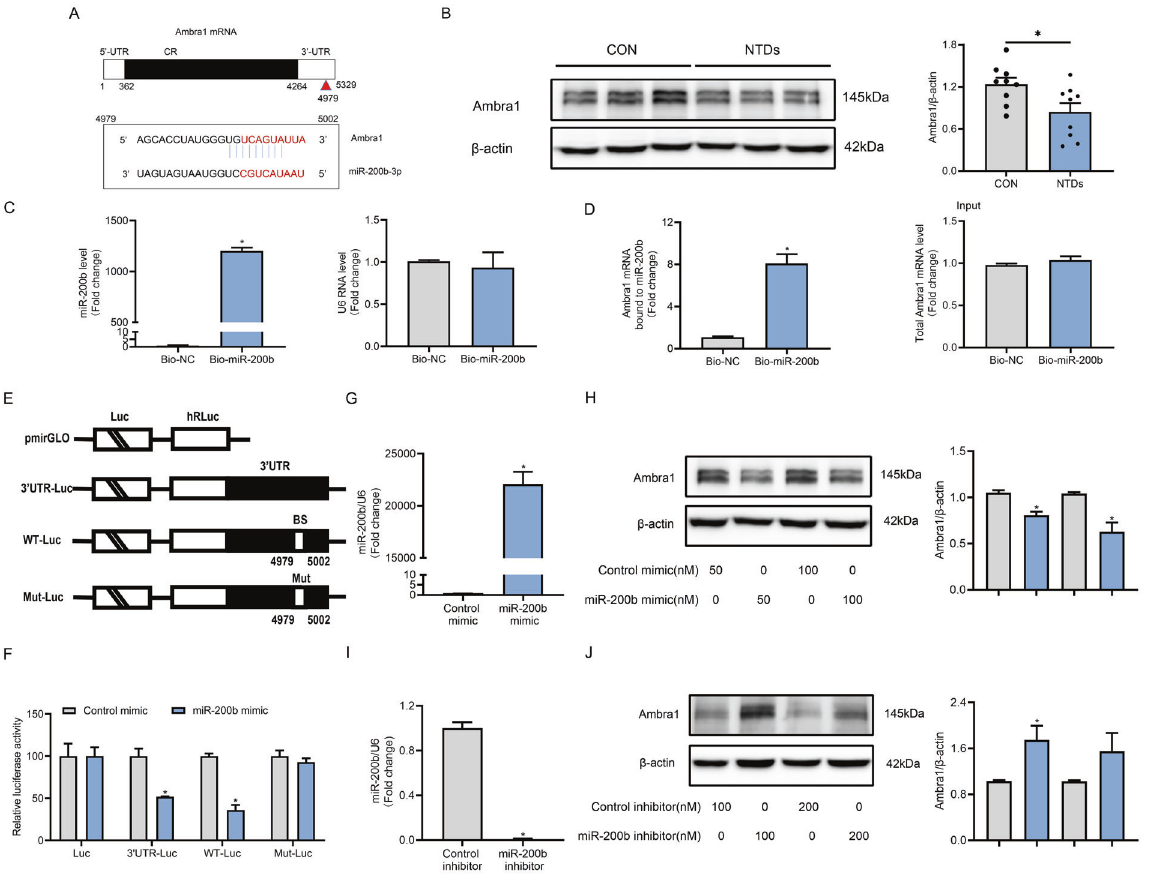
Fig. 3 miR-200b binds to 3 ʹ -UTR of Ambra1 mRNA and inhibits Ambra1 translation. A Schematic representation of Ambra1 mRNA, depicting a potential miR-200b binding site (BS) located in Ambra1 3 ′ -UTR. B Western blot of Ambra1 in E9.5 mouse embryos and quanti fi cation of Ambra1 protein in the control and NTD groups ( n = 9). C Abundance of miR-200b and U6 examined by RT-qPCR after 48 h of biotin-miR-200b transfection. D Ambra1 mRNA levels detected in the lysates precipitated by biotin-miR-200b and the total input. E